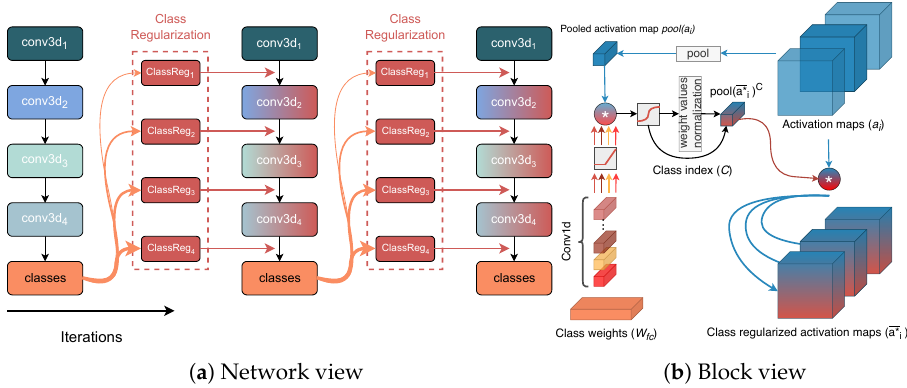
Figure 1. Class Regularization . An additional pathway between class weights and intermediate features is added ( a ) connecting different parts of the network across iterations. In Class Regularization blocks, activation maps are pooled to vector volumes (pool( a i )) and multiplied by the class weights ) C ) . A computational overview of the in order to select the resulting highest class activation (pool ( a ∗ i in-block operations ( b ) appears in Algorithm